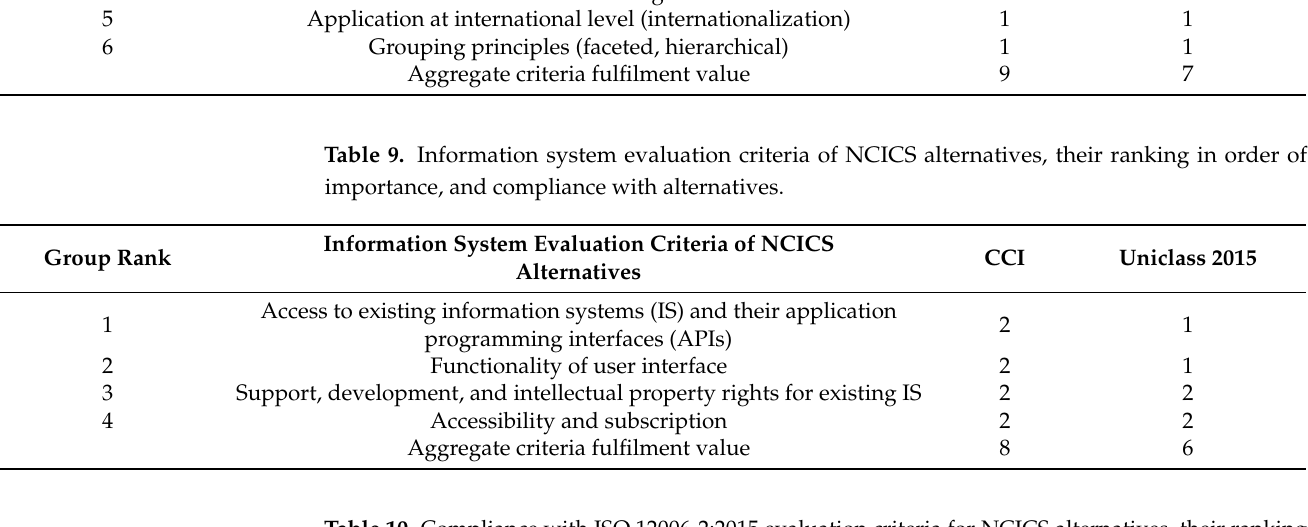
Table 10. Compliance with ISO 12006-2:2015 evaluation criteria for NCICS alternatives, their ranking in order of importance, and compliance with alternatives.